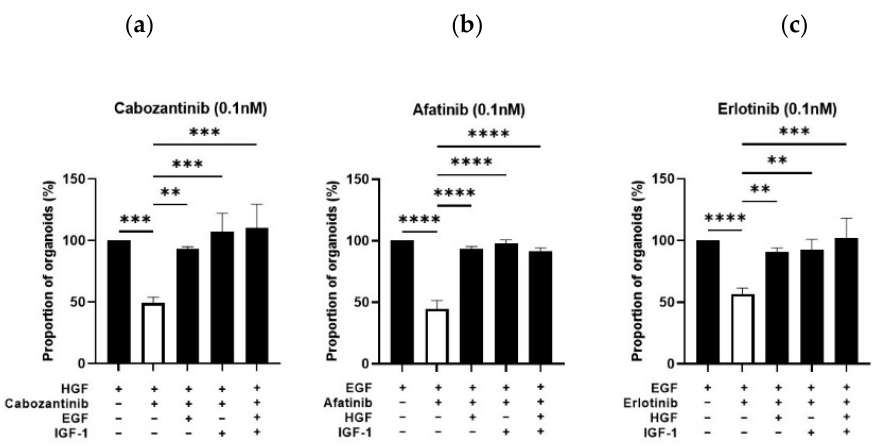
Figure 9. Growth factors rescue the ability of Pten-null mouse LSC med cells to generate organoids in the presence of receptor tyrosine kinase inhibitors. ( a ) Effect of EGF and/or IGF-1 on the ability of LSC med cells FACS-enriched from Pten-null mouse prostates to generate organoids in the presence of HGF and Cabozantinib. ( b , c ) Same as in panel a, with HGF and/or IGF-1 in the presence of EGF and Erlotinib ( b ) or Afatinib ( c ). See Table S2 for the concentrations of growth factors added to culture medium. These data were obtained from 3 experiments each involving 1 or 2 animals.